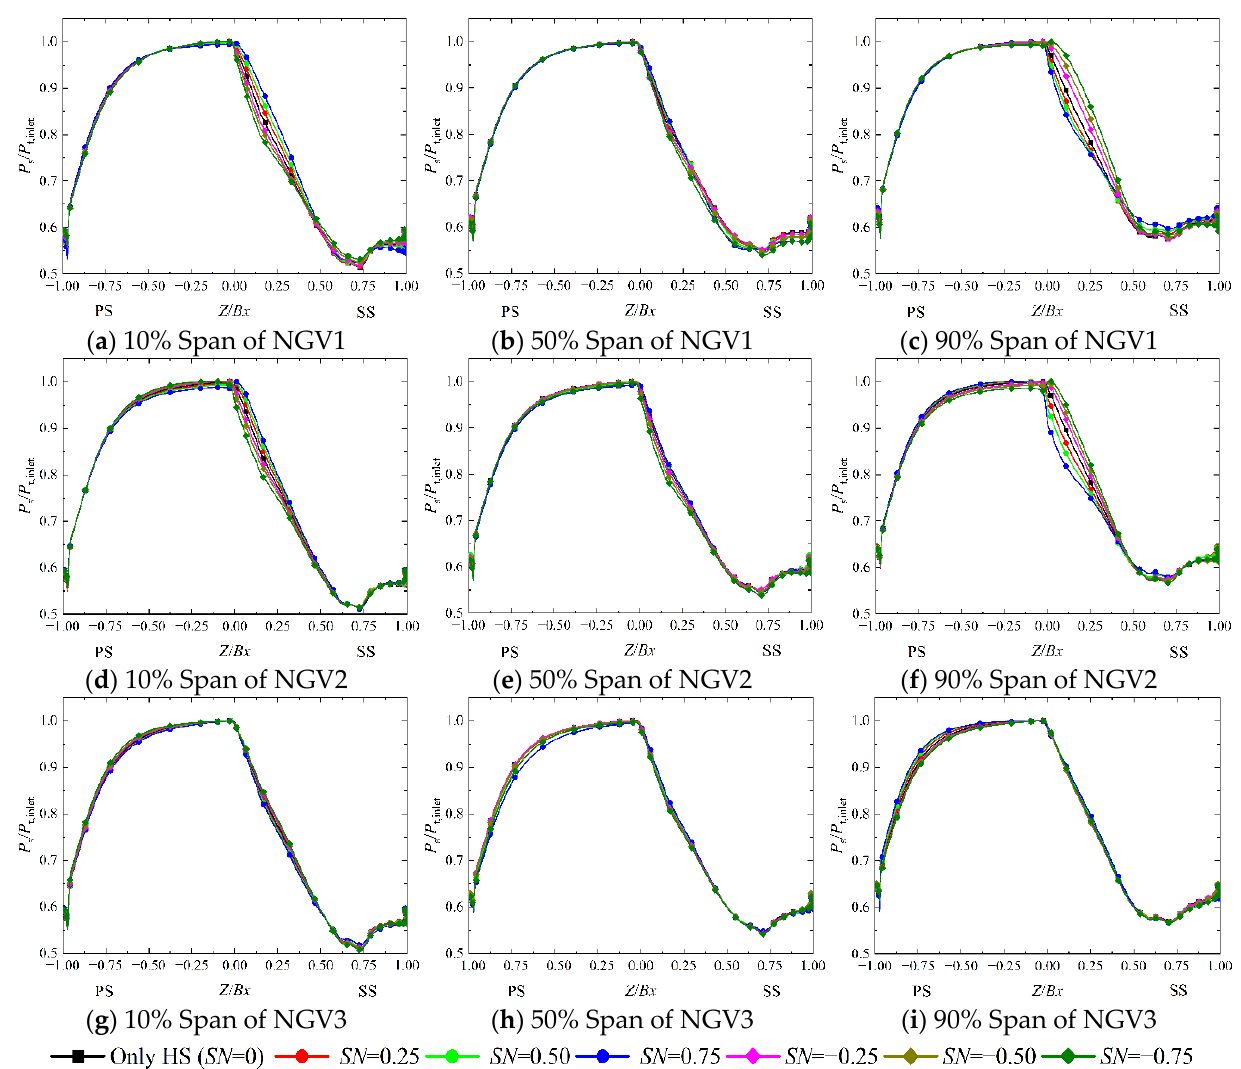
Figure 14. Effect of swirl intensifies on pressure distributions at different spans.